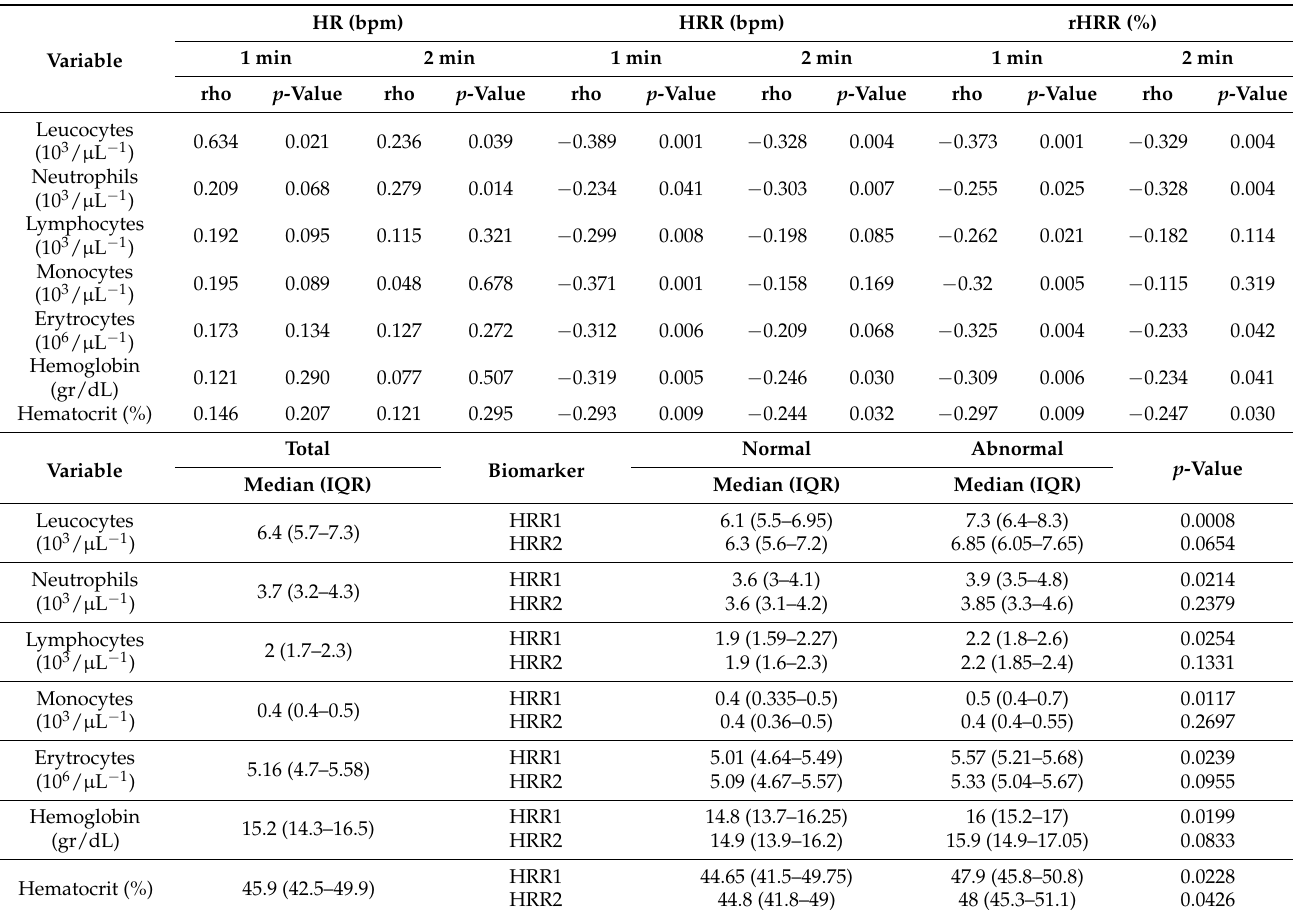
Table 5. Correlation between heart rate, heart rate recovery at 1 and 2 min, relative heart rate recovery and hematic biometry. Comparative differences in white blood cell counts and red blood cell parameters between normal and abnormal